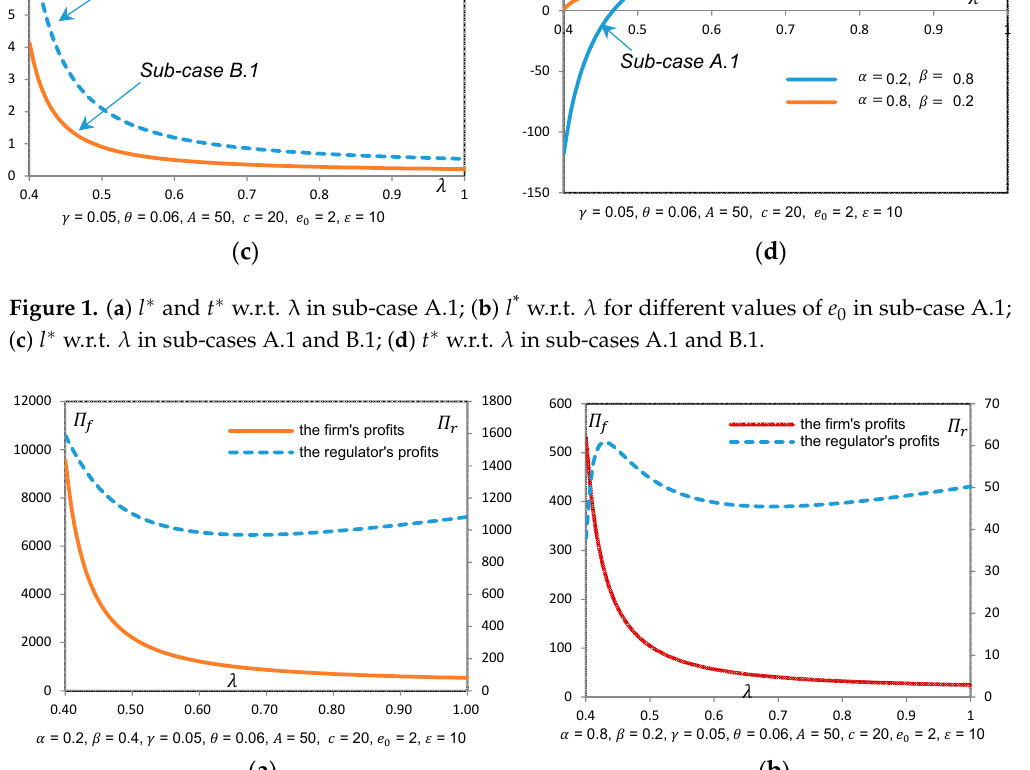
< 2 ) < 2 ) (cid:2870)(cid:3080)(cid:3030)(cid:3032) (cid:3116) (cid:2870)(cid:3080)(cid:3030)(cid:3032) (cid:3116)